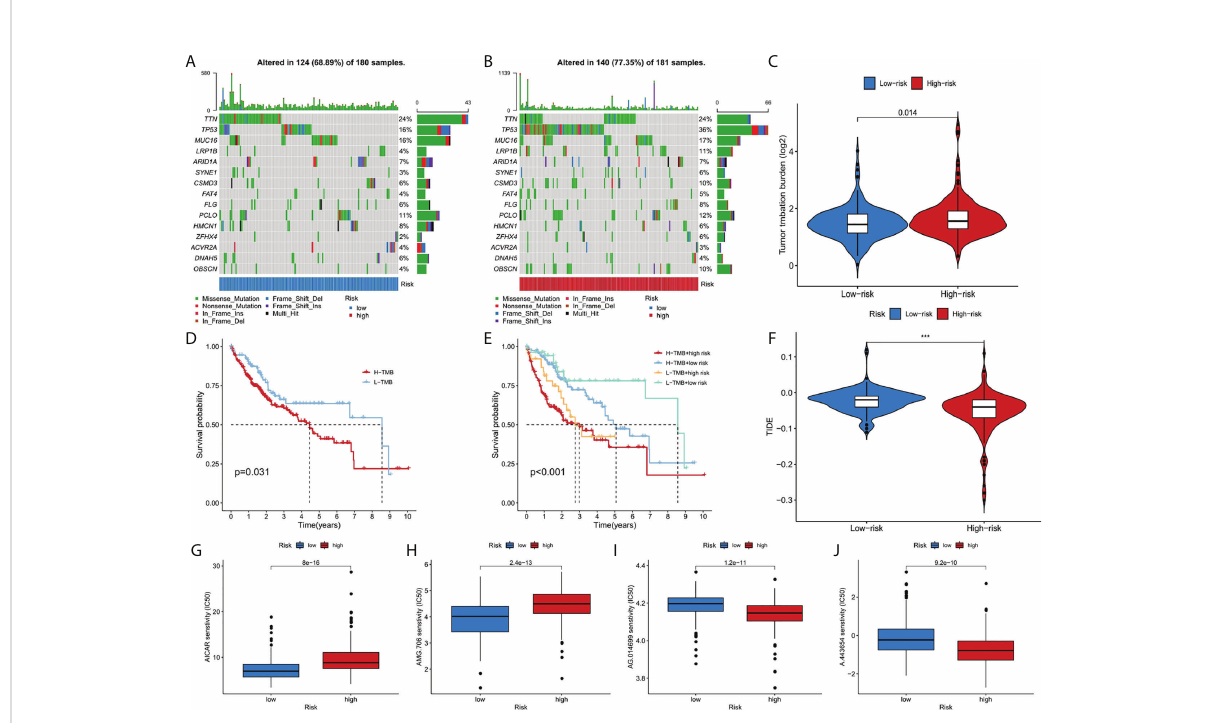
FIGURE 6 The relationship between TMB and the 9-gene signature. (A, B) The oncoplots of the mutation genes in liver cancer patients for the high-risk and low-risk groups. (C) Higher TMB levels correlated with high-risk group. (D) Higher TMB level demonstrated poorer OS. (E) Kaplan-Meier curves for patients by both risk score and TMB. (F) Higher TIDE levels correlated with low-risk group. (G-J) Drug sensitivity analysis. ***p <